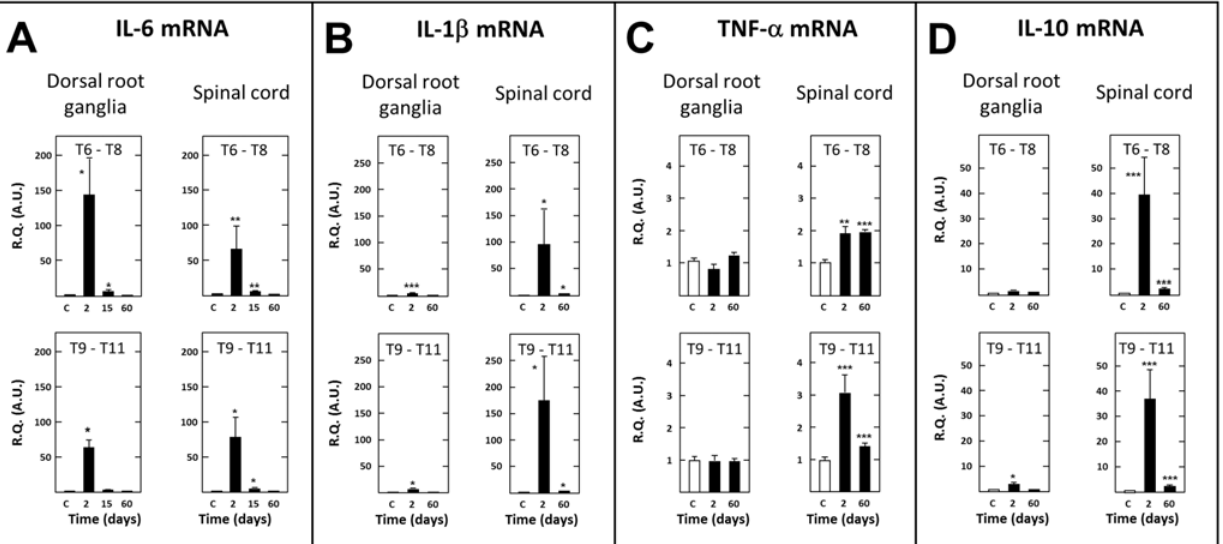
Fig 8. Short- and long-term changes in levels of transcripts encoding IL-6 (A), IL-1 β (B), TNF- α (C) and IL-10 in dorsal root ganglia and spinal tissues in spinal cord-transected rats. Real-time RT-qPCR determinations were made in T6 – T8 and T9 – T11 dorsal root ganglia and T6 – T8 and T9 – T11 spinal segments at day (D) 2, 15 or 60 (abscissa) after spinal cord transection at T8 – T9 level. Data are expressed as the ratio of specific mRNA over GaPDH mRNA [R.Q.(A.U.)]. Each bar is the mean + S.E.M. of n independent determinations (D2, D15: n = 6; D60: n = 12). Sham values at every postoperative time are pooled under “ C ” (control) on abscissa. * P < 0.05, ** P < 0.01, *** P < 0.001 compared to respective values in sham-operated rats (C). Two-way ANOVA followed by Bonferroni test.